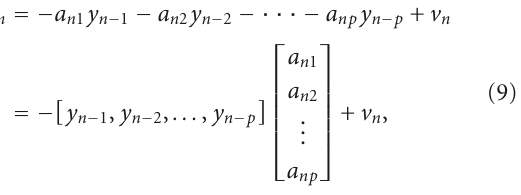
Figure 5: Typical segment of ECG BW noise (a) original and (b)